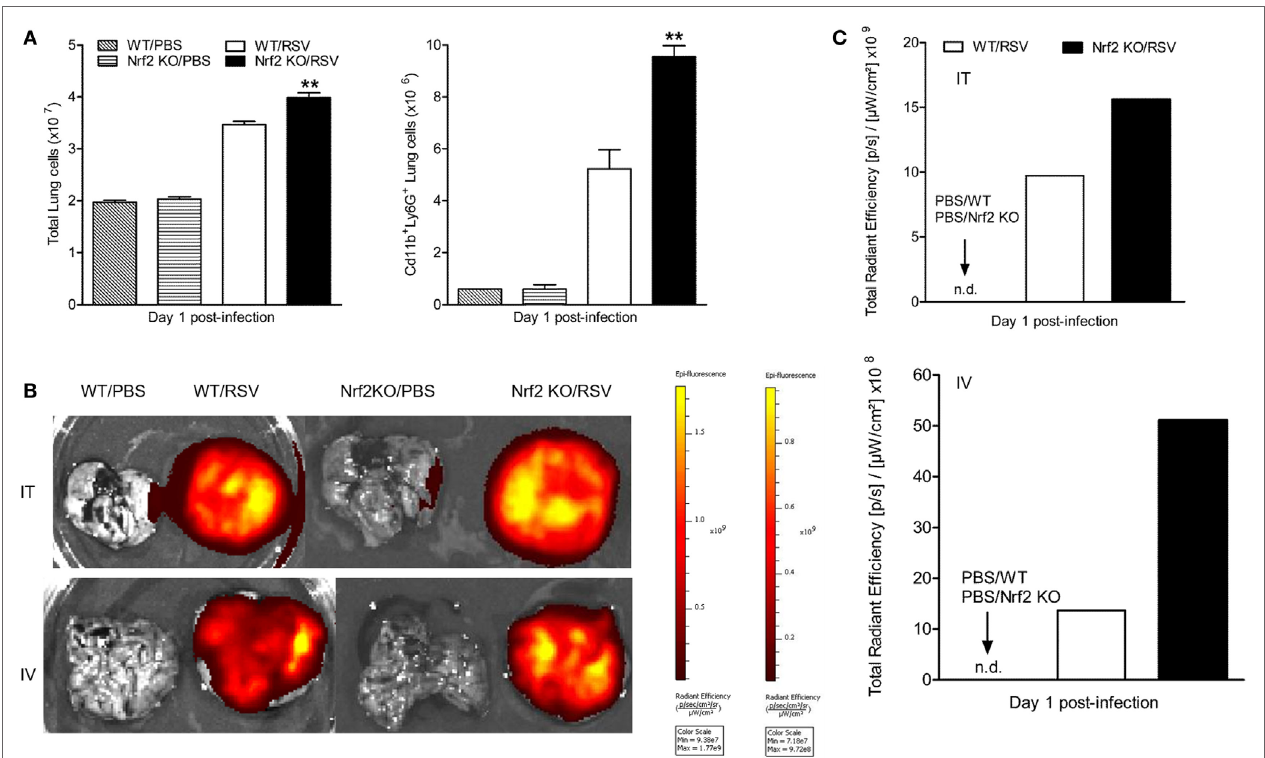
FigUre 4 | NF-E2-related factor 2 (Nrf2) deficiency leads to increased neutrophil infiltration in the lungs in response to respiratory syncytial virus (RSV) infection. Nrf2 KO and wild typr (WT) mice were infected with RSV or PBS and lungs collected at day 1 post-infection. (a) Neutrophils (CD11b + Ly6G + ) recruitment to the lung by flow cytometry analysis. Imaging (B) and quantification (c) of lung neutrophils using the near infrared fluorescent imaging agent by intratracheal (i.t., upper panels) or intravenous tail injection (i.v., lower panels). Fluorescence intensity is represented in the images with a pseudocolor scale ranging from yellow (most intense) to dark red (least intense) and quantified in specific total radiant efficiency per lung region of efficiency, using the Living Image software. The bar graph represents mean ± SEM ( n = 2–4 mice/group). ** p < 0.01 when compared with WT/RSV